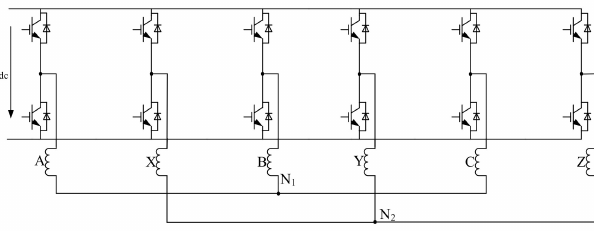
Figure 1. Six-phase inverter topology with double three-phase windings and isolated neutral point.